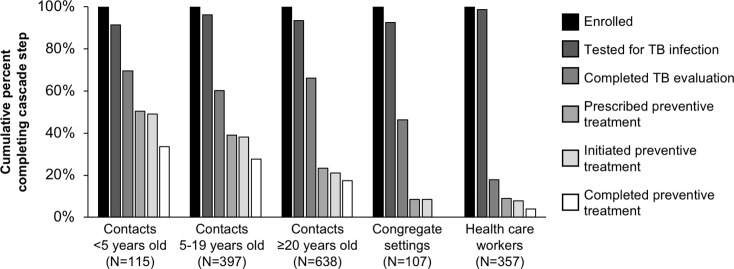
TB preventive treatment care cascade for contacts, people in congregate settings, and health care workers.Cumulative completion of each cascade step is calculated by calculating the percent who completed each step out of those eligible to complete it and then multiplying these percentages.